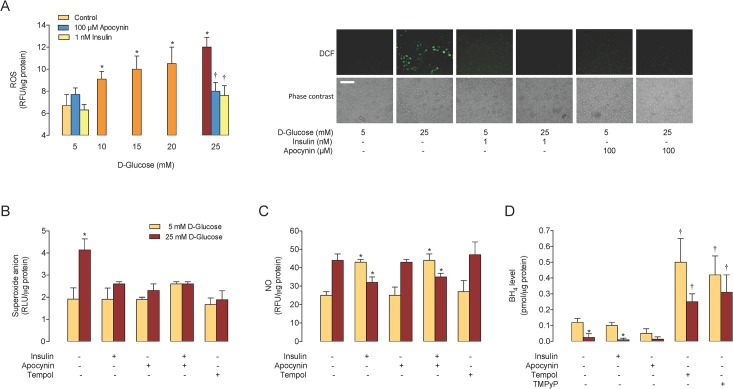
High D-glucose–modulation of ROS, O2
•– and BH4 generation.A, Reactive oxygen species (ROS) in HUVECs pre-incubated (24 hours) with D-glucose at different concentrations. Relative fluorescence units (RFU) was measured in cells preloaded (30 minutes) with 5-(and-6)-chloromethyl-2',7'-dichlorodihydrofluorescein diacetate (DCF) in the absence or presence of apocynin or insulin. Control is fluorescence in cells in 5 mmol/L D-glucose in the absence of insulin or apocynin. Left panel. ROS level (as DCF fluorescence) in the absence (–) or presence (+) of apocynin or insulin in cells incubated with 5 or 25 mmol/L D-glucose. Bar indicates 200 μm at 10x microscopy magnification. B, The superoxide anion (O2
•–) level in cells pre-incubated (24 hours) with 5 or 25 mmol/L D-glucose in the absence (–) or presence (+) of 1 nmol/L insulin, 100 μmol/L apocynin or 1 mmol/L tempol, measured as relative luminescence units (RLU) in cells preloaded (30 minutes) with 10 μmol/L lucigenin. C, Nitric oxide (NO) level in cells as in B, measured as RFU in cells preloaded (30 minutes) with 4-amino-5-methylamino-2',7'-difluorofluorescein. D, BH4 level measured by HPLC in cells as in B, and in the absence or presence of 100 μmol/L Mn(III)TMPyP (TMPyP). In A, *P<0.03 versus Control. †P<0.04 versus corresponding values in 25 mmol/L D-glucose. In B, *P<0.03 versus all other values. In C, *P<0.03 versus corresponding values in the absence of insulin, apocynin or tempol. In D, *P<0.05 versus corresponding values in 5 mmol/L D-glucose, †P<0.03 versus corresponding values in the absence of insulin, apocynin, tempol or Mn(III)TMPyP. Values are mean ± S.E.M. (n = 4–7).